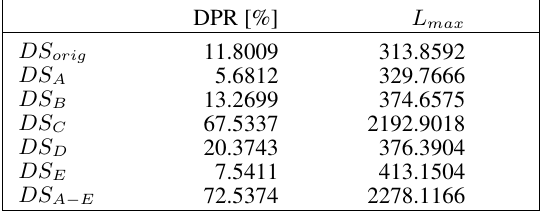
Table 5. Performance measures for the track detection (detection performance ratio DPR, and the maximal length L max of the connected components) regarding the individual data sets.